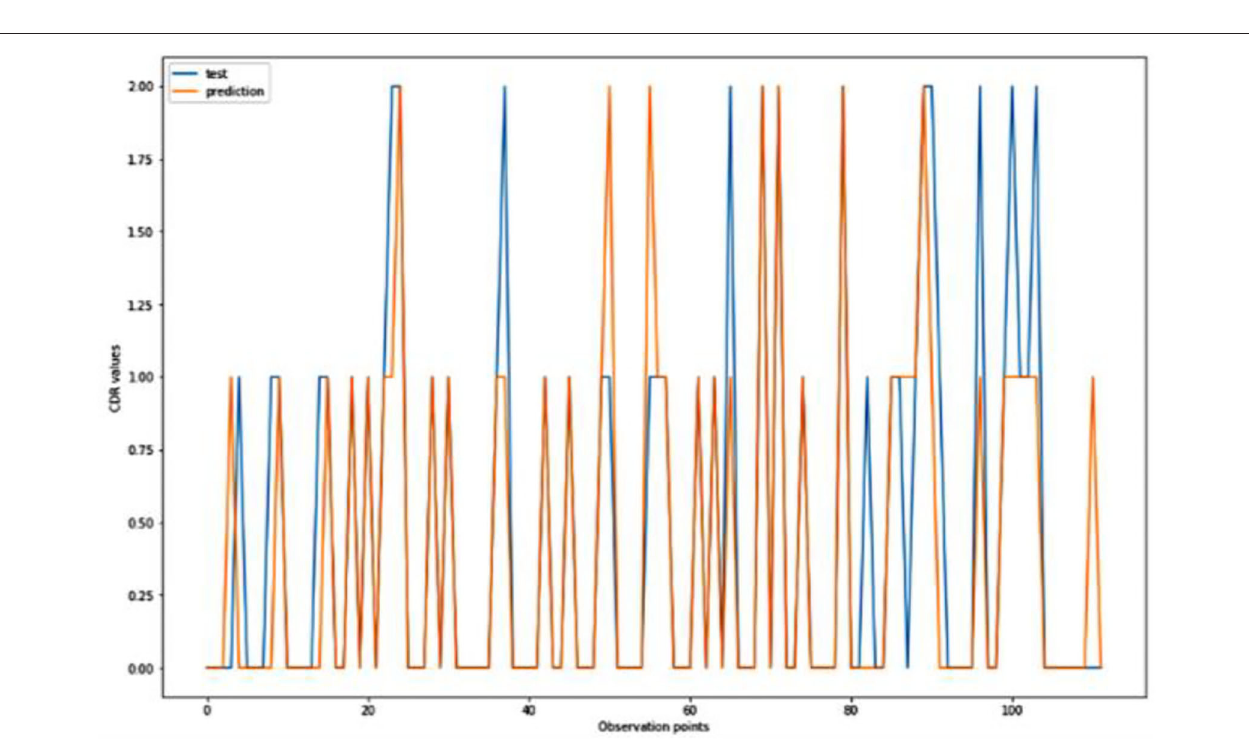
Frontiers in Public Health |